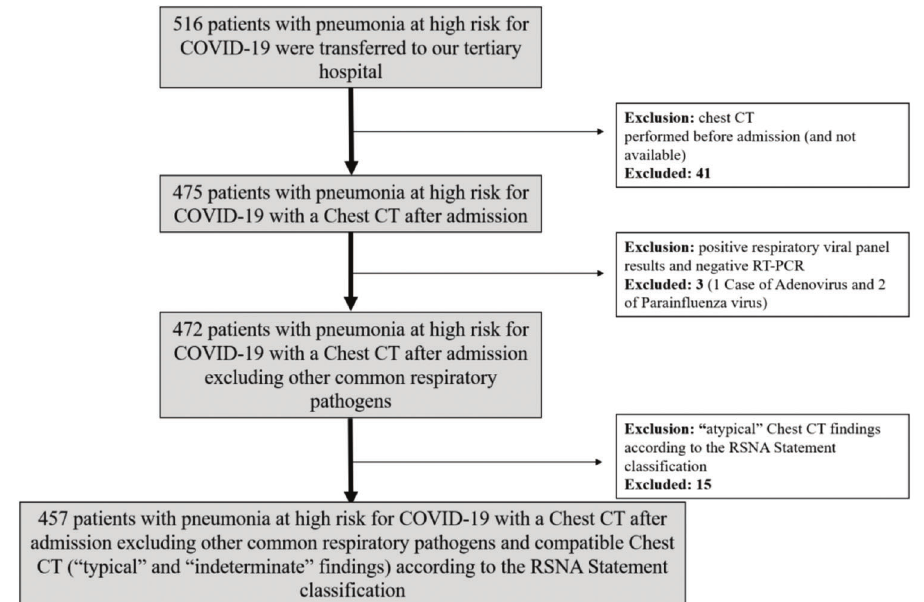
Figure 1 - Flow diagram of patients ’